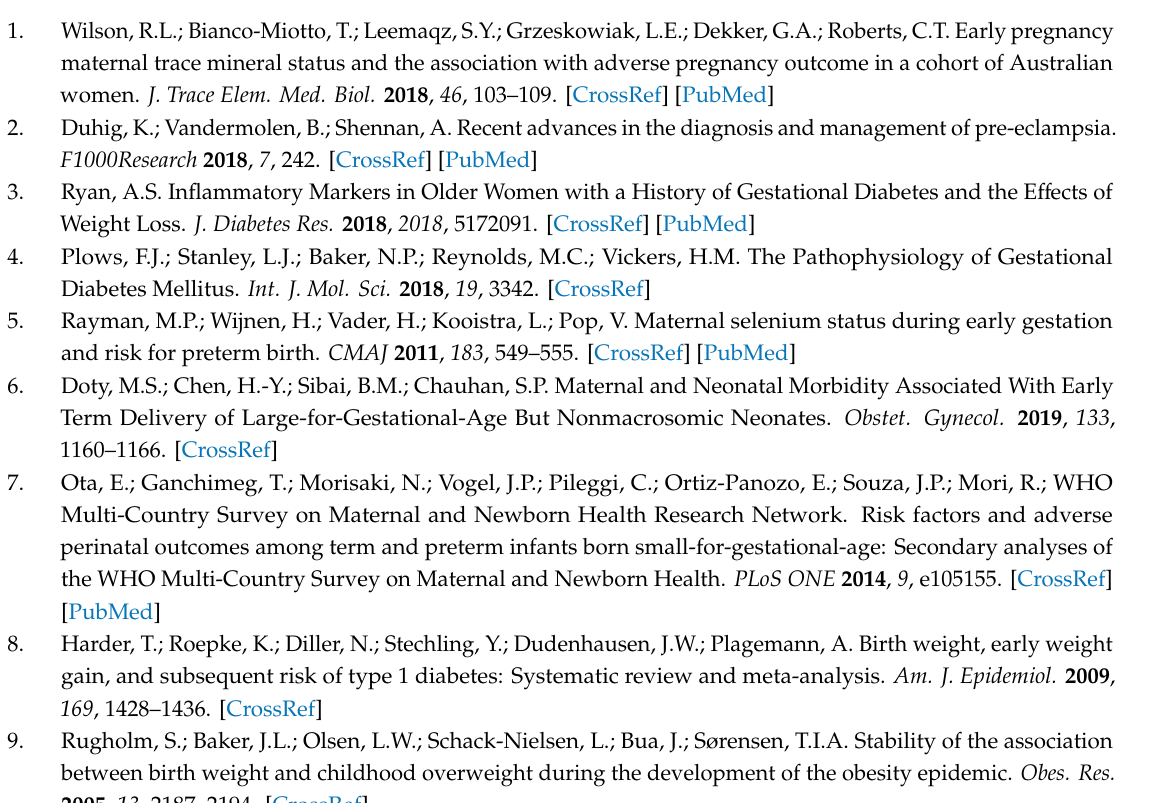
Table S1: Full characteristics of microelement levels (medians and ranges) for various maternal characteristics, Table S2: The adjusted relationships between maternal characteristics and microelement levels after additional adjusting for pregnancy-induced hypertension (PIH), Table S3: Full characteristics of microelement levels (medians and ranges) for pregnancy results, Table S4: Adjusted relationships between pregnancy results and microelements in the multivariable linear regression, Table S5: Short characteristics of mothers in the control and case groups (for PIH and preterm